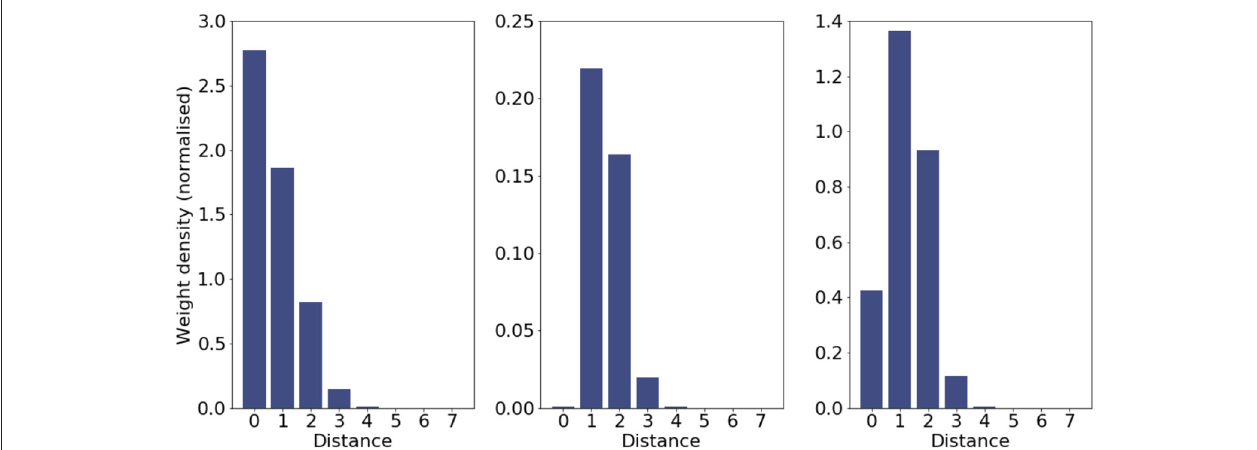
FIGURE 2 | STDP behavior at an autapse and its influence on rewiring. The bar charts show the weight density of incoming lateral synapses (c.f. Figure 2 in Bamford et al., 2010) for the initial connectivity (Left) ; final connectivity including weights (Middle) ; and final connectivity with unit weights (Right) . The second plot shows that synapses at a distance of 0 (autapses) are maximally depressed, and the rewiring rule heavily prunes them.